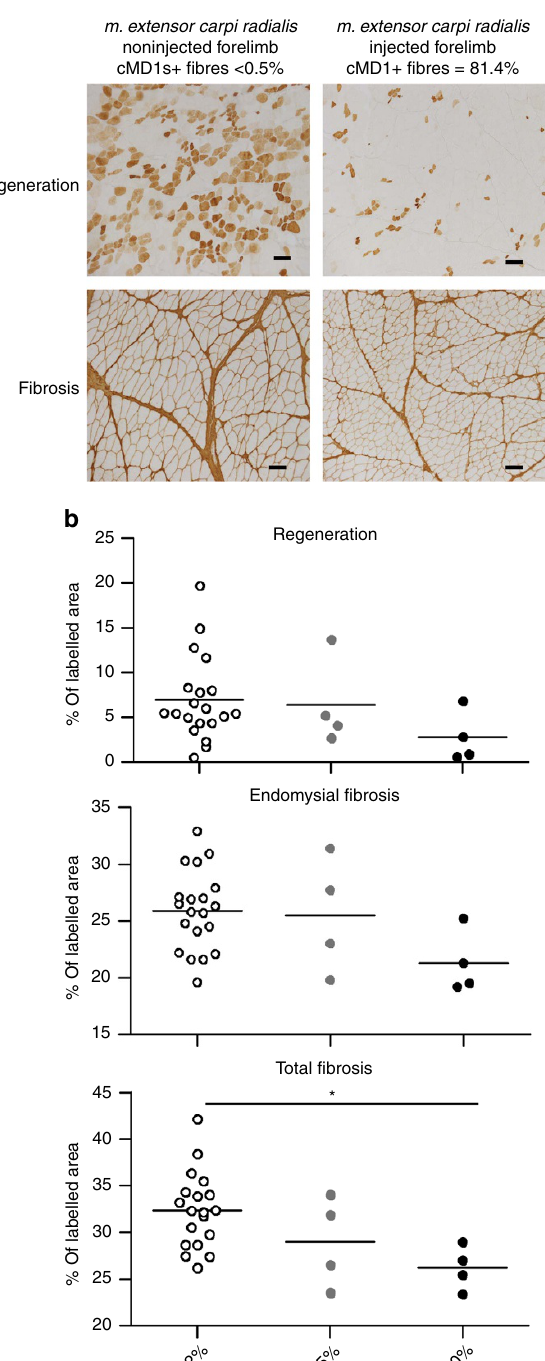
Figure 2 | Improvement of pathological pattern in the cMD1-expressing muscles. After killing, two muscles (the flexor carpi ulnaris muscle and the extensor carpi radialis muscle) in each forelimb of each GRMD dog injected by the LR route either with the rAAV2/8-Spc5.12-cMD1 vector ( n ¼ 4 dogs and 16 muscles analysed) or with buffer ( n ¼ 3 dogs and 12 muscles analysed) were analysed. Myofibre regeneration was evaluated by immunohistochemical staining of myofibres using an antibody specific for developmental myosin heavy chain isoform. Total and endomysial fibrosis were evaluated by immunohistochemical detection of Collagen I. ( a ) Regeneration and fibrosis immunostaining on transverse sections of muscle samples. Representative results are presented for two muscles of dog LR1 (noninjected forelimb and injected forelimb). The levels of cMD1- positive fibres detected by immunostaining from the same muscle samples are indicated above each panel. Scale bar, 100 m m. ( b ) Regeneration, total fibrosis and endomysial fibrosis quantification in the total of 28 muscles analysed in the GRMD dogs injected by the LR route, either with the rAAV2/8-Spc5.12-cMD1 vector or with buffer was done using an automatic measurement of the percentage of the labelled area after selection of regions of interest. Analyses were done according to the percentage of cMD1-positive fibres of each muscle: o 12% ( n ¼ 20, empty symbols), between 30 and 45% ( n ¼ 4, grey full symbols) and between 46 and 90% ( n ¼ 4, black full symbols). Each point represents the data obtained in one muscle, and the horizontal bars represent the mean of the values obtained for each group * P o 0.05 (nonparametric Kruskal–Wallis test with post hoc multiple comparison Dunn’s